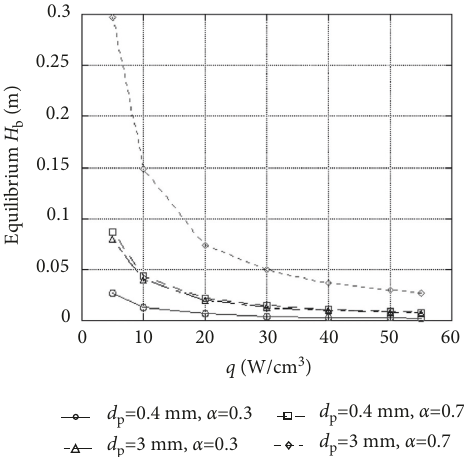
Figure 14: Extrapolation analyses to actual reactor conditions by the onset model